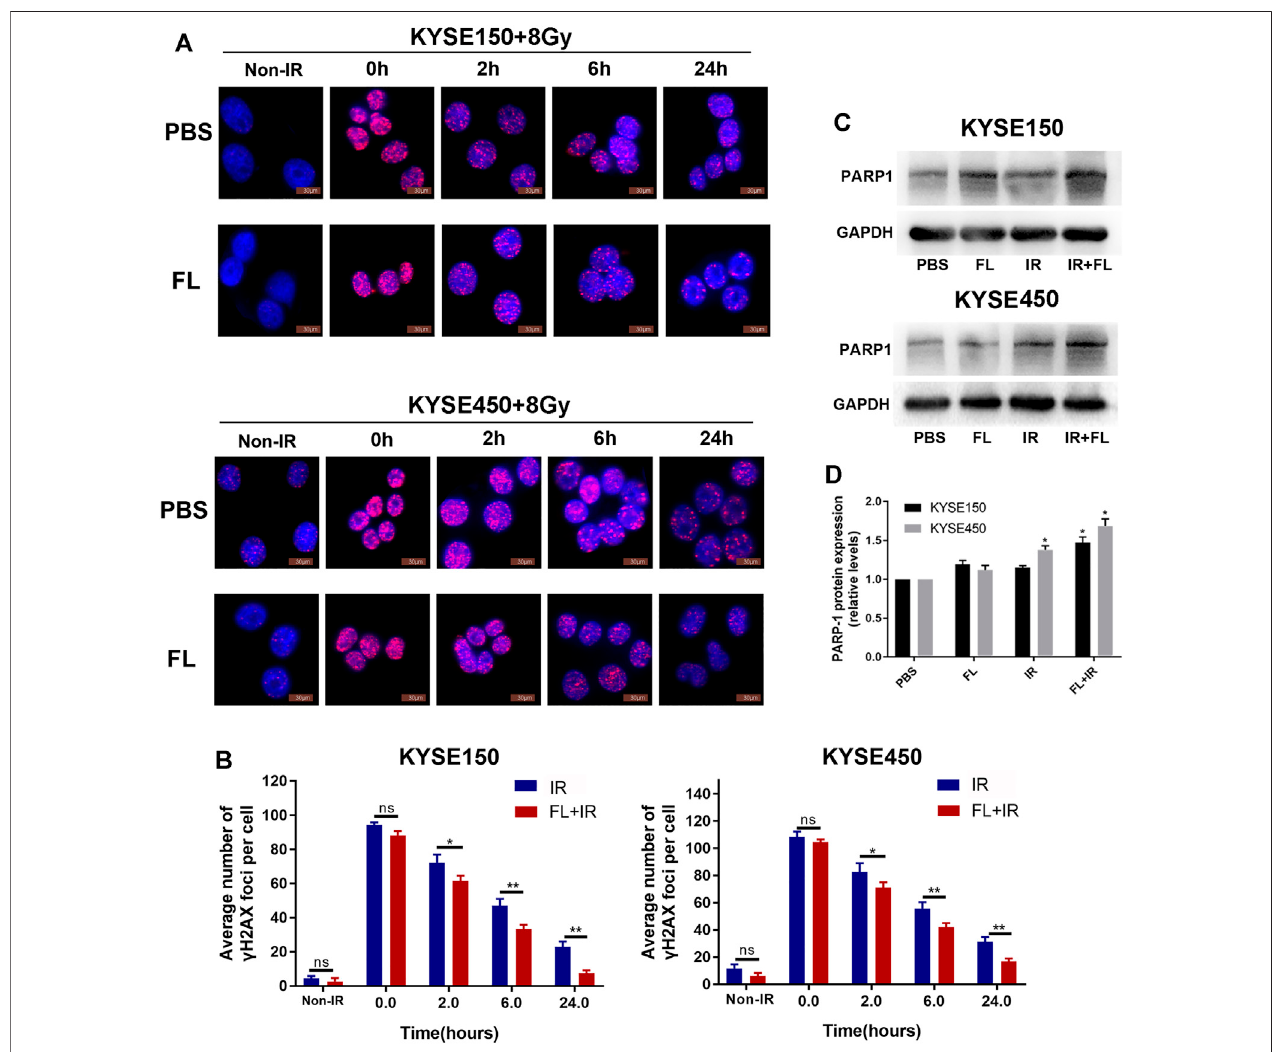
FIGURE 3| FL reduces IR-induced DNA damage level and increases DNA repair. (A,B) Immuno fl uorescence detection of γ H2AX foci in PBS groups or 200 ng/ml FL administration for 24 h groups after 8 Gy radiation different time. Mean ± SEM, N (cid:2) 3, * p < 0.05, ** p < 0 0.01 (C,D) PARP1 protein expression in PBS groups or 200 ng/ml FL administration for 24 h groups after 24 h of 8 Gy radiation. GAPDH is an internal